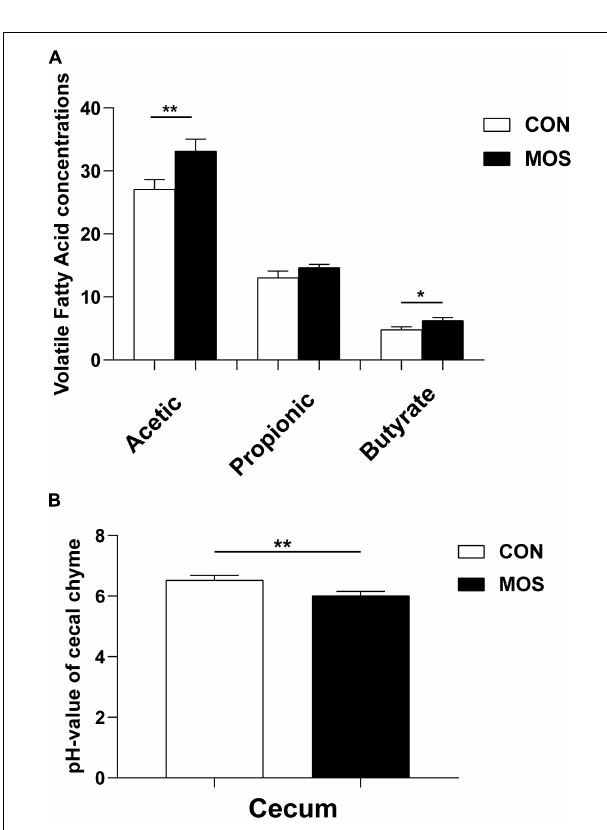
FIGURE 3 | Quantitative PCR analysis of 16S rRNA gene copy numbers in the intestinal digesta. Ileum (A) and cecum (B) digesta samples were collected from pigs fed with the basal diet (CON) or a basal diet supplemented with 3 g/kg MOS (MOS) ( n = 8). ** p < 0.05.